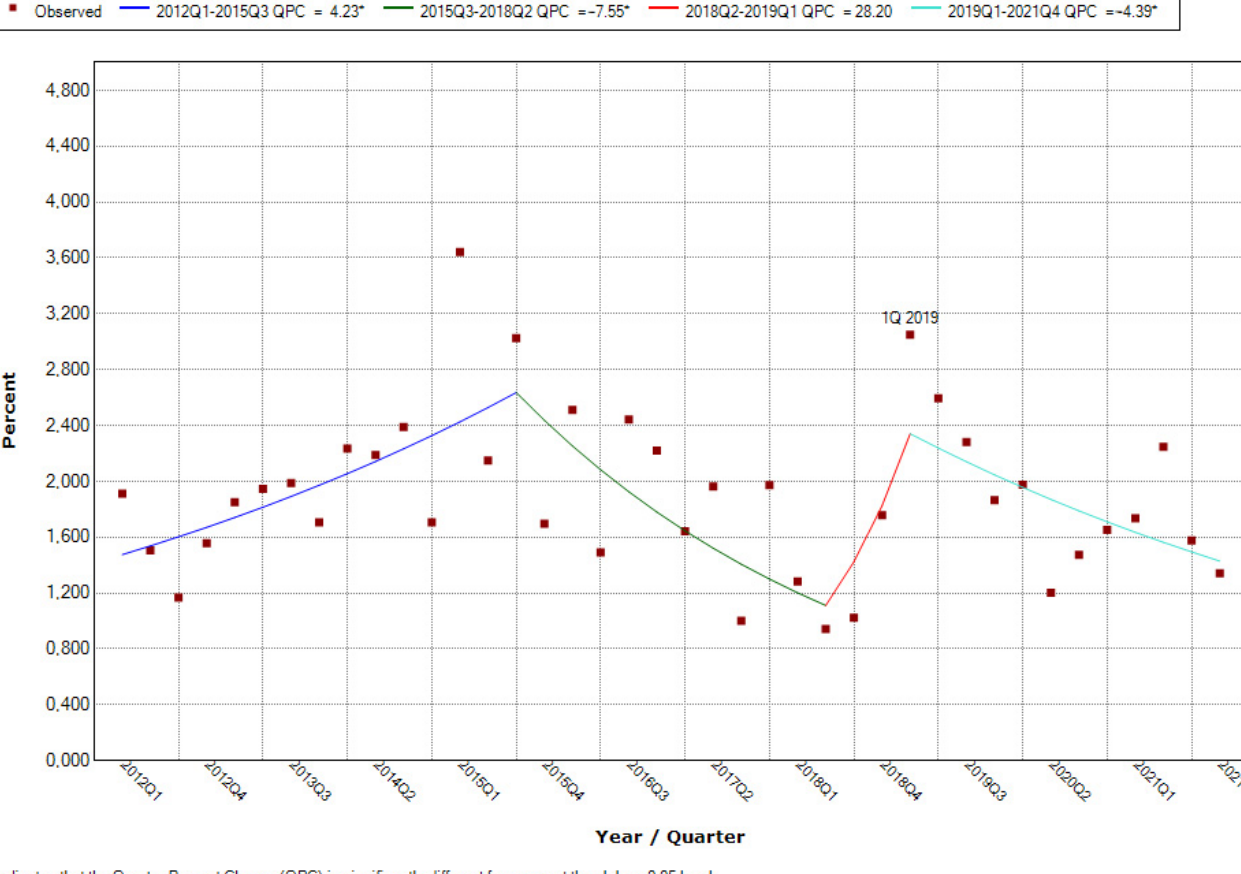
Figure A36. Percentage of products containing beta-alanine in individual quarters in the period from 2012 to 28 November 2021. Joinpoints mark trend turning points. The date above the observation indicates the moment of publication of the scientific opinion/resolution.